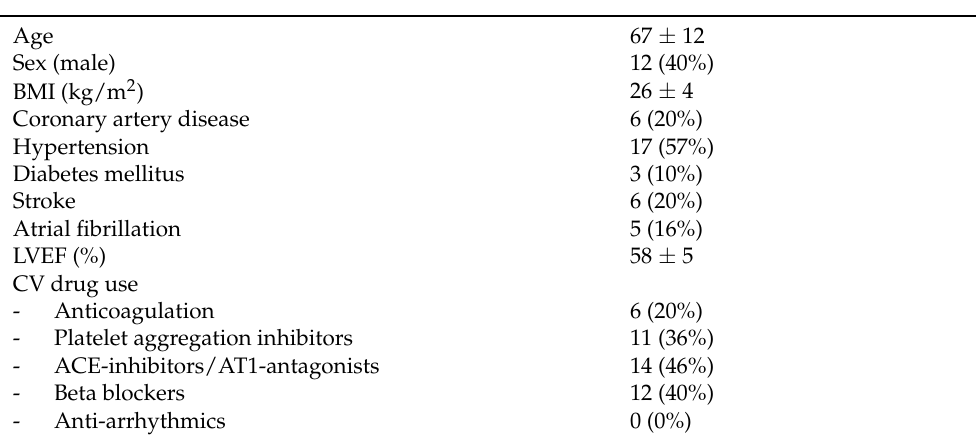
Table 1. Baseline characteristics.